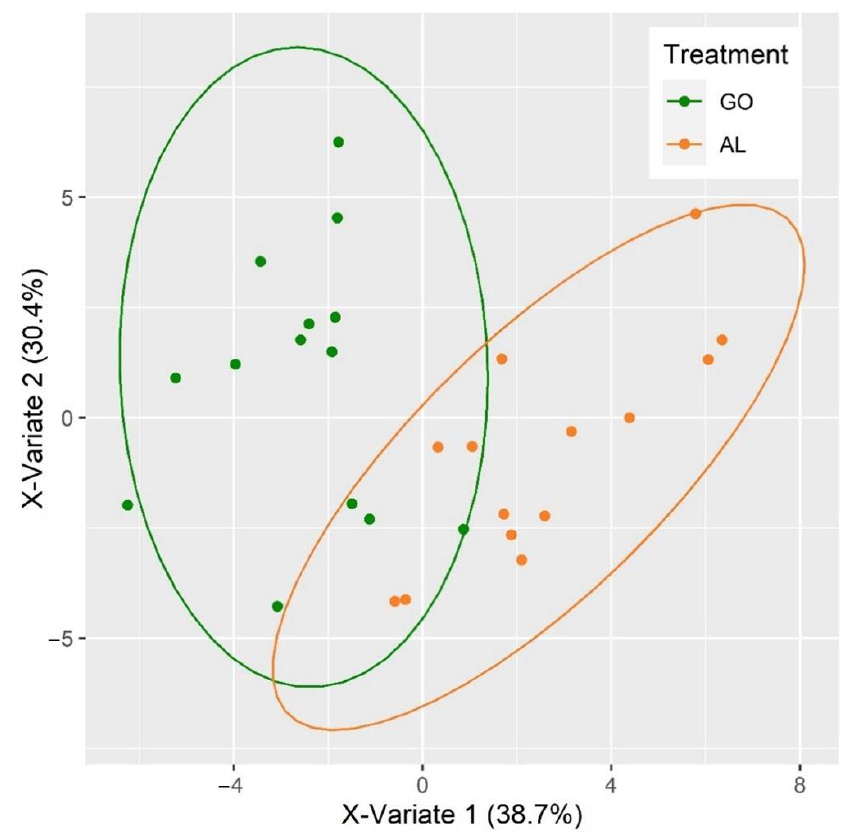
Figure 3. Score plot of the PLS-DA model for classification of G0 and AL samples build with spectra collected after exposure to air for 24 h and pre-processed using the Savitzky–Golay algorithm.